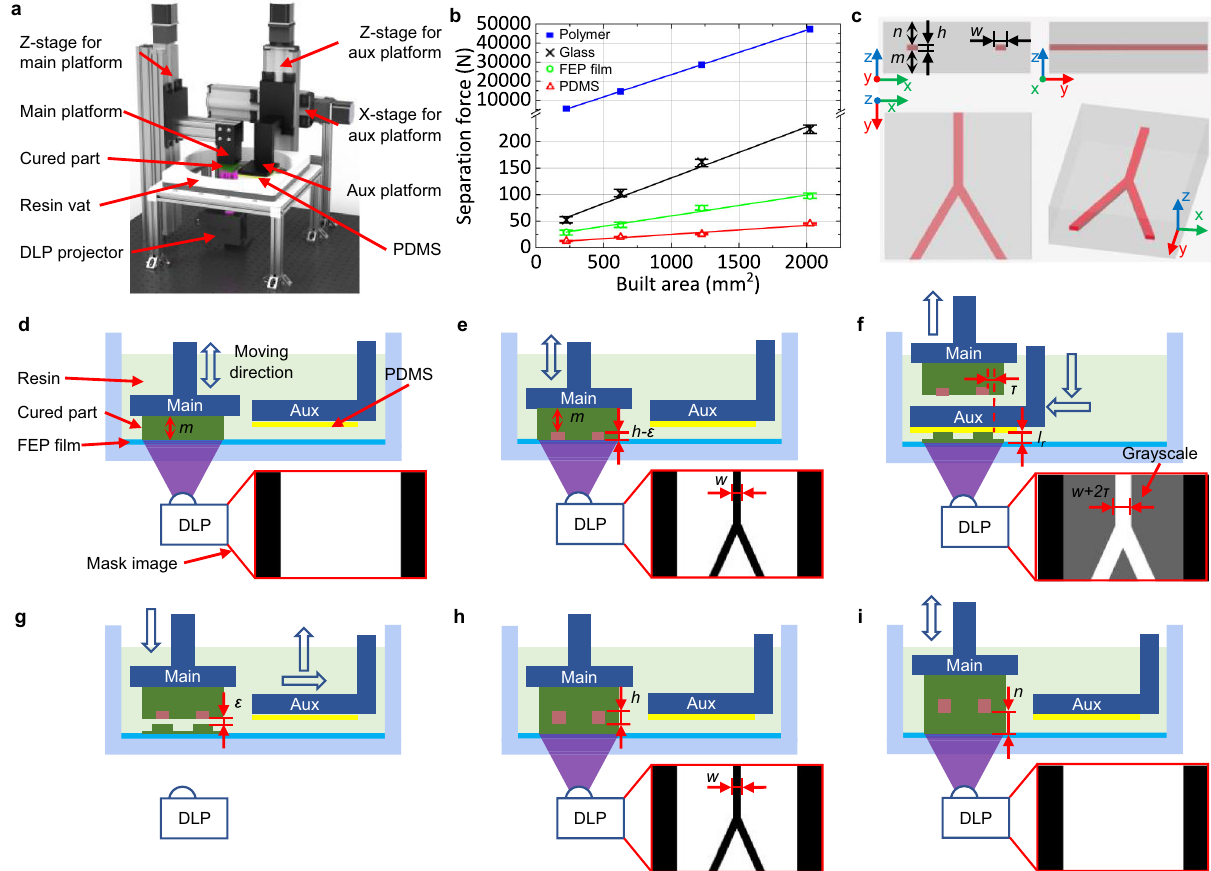
Fig. 2 Principle of IsT-VPP process. a The detailed structure of the IsT-VPP apparatus. b Measured separation forces of different contact areas for different material interfaces during VPP printing. Given the same contact area, the separation force between the part and the aux platform corresponding to the polymer-PDMS interface is the smallest. The separation force between the part and the vat surface represented by the polymer- FEP fi lm interface is larger than the polymer-PDMS interface. A glass sheet works as the main build platform because the polymer-glass interface has stronger bonding than the previous two interfaces and is weaker than the polymer-polymer interface. The bonding force between neighboring layers of the printed part is derived from the resin ’ s ultimate strength. c A simpli fi ed Y-junction fl uidic mixer model is used to illustrate the IsT-VPP process and its three orthographic views. d , e Fabrication of the bottom portion and partial channel using only the main build platform and the corresponding projection images. f Fabrication of the channel roof using the aux platform and the corresponding grayscale mask image. g , h In-situ transfer of the channel roof to the previously built part with bonding connection in the Z -direction via the second exposure and the corresponding mask image. i Fabrication of the rest of the part using the main build